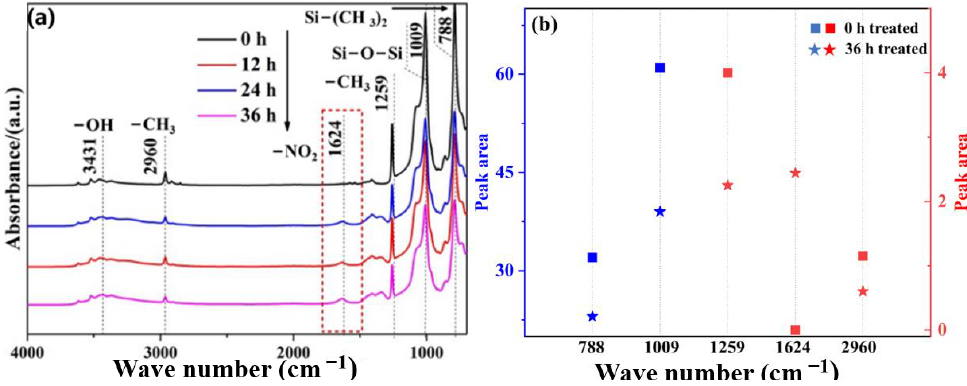
Figure 7. Infrared spectrum ( a ) and organic group peak area changes ( b ) in ATH-180 SiR after aging with NO 2 for different times.